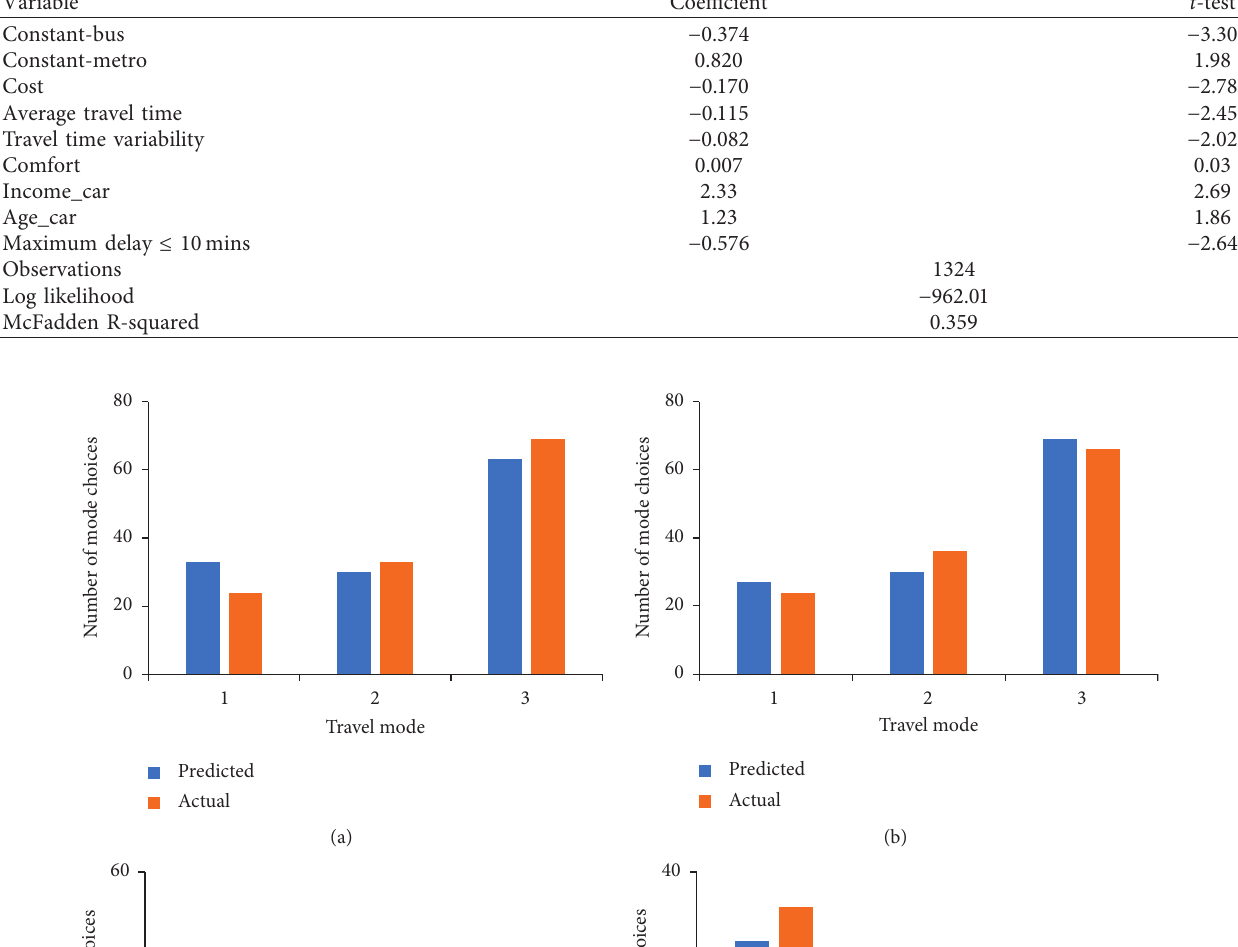
Table 4: Estimated results with socioeconomic factors and restrictions (Model 2).